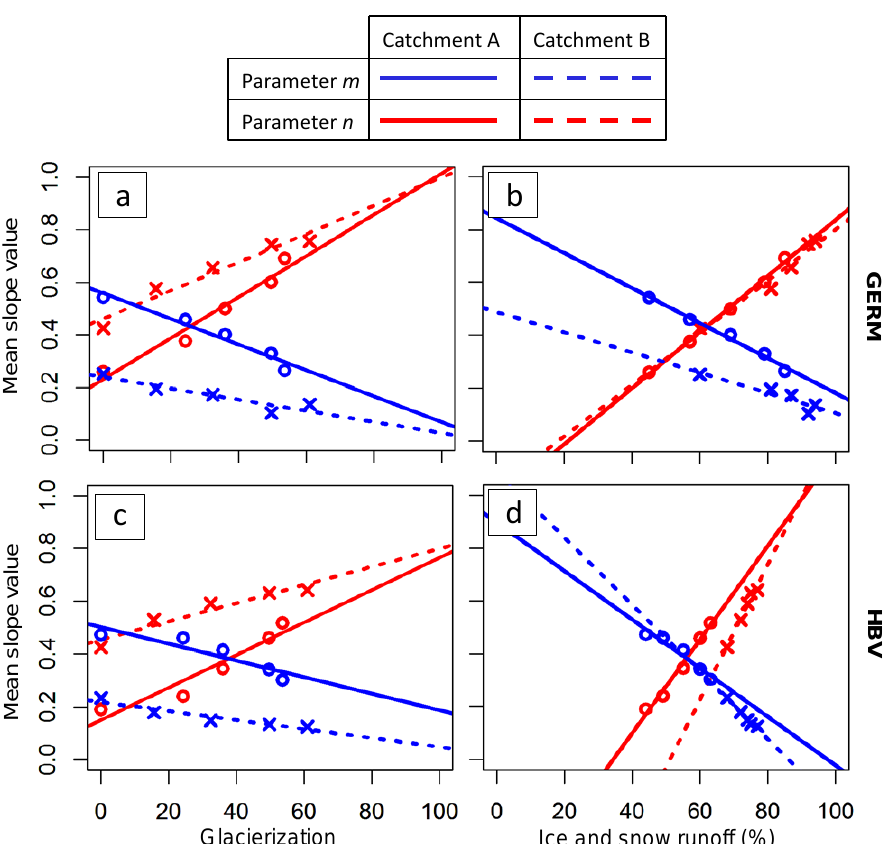
Figure 7. Mean values (mean over all lead times) of parameters m and n (cf. Equation (7)), and their relation to ( a + c ) glacierization and ( b + d ) the sum of ice and snow melt. Panels ( a ) + ( b ) and ( c ) + ( d ) refer to the GERM and HBV model, respectively. Results refer to the RMSE skill